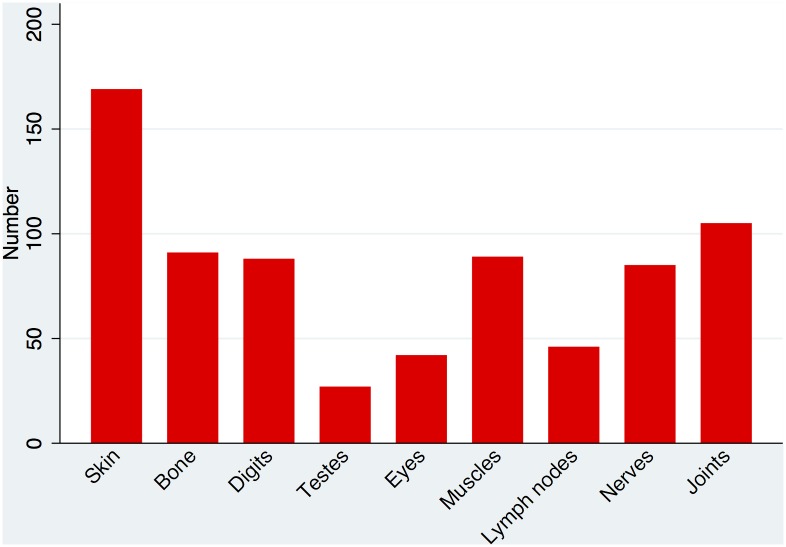
Location of pain in ENL.